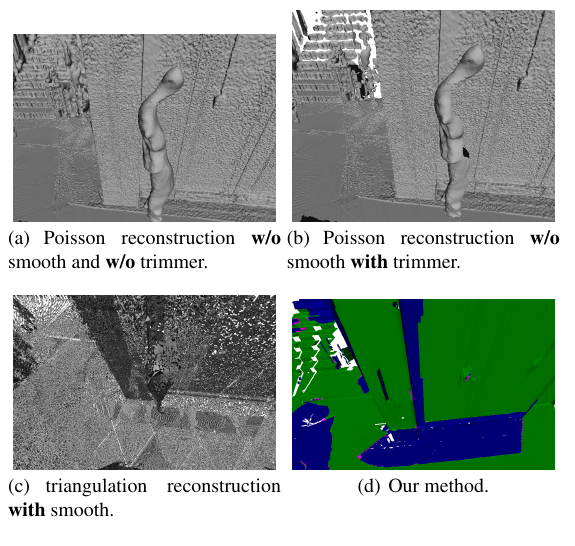
Figure 14. A comparison if there is a shortly static person with Poisson reconstruction(implicit method) and triangulation recon- struction(explicit method).